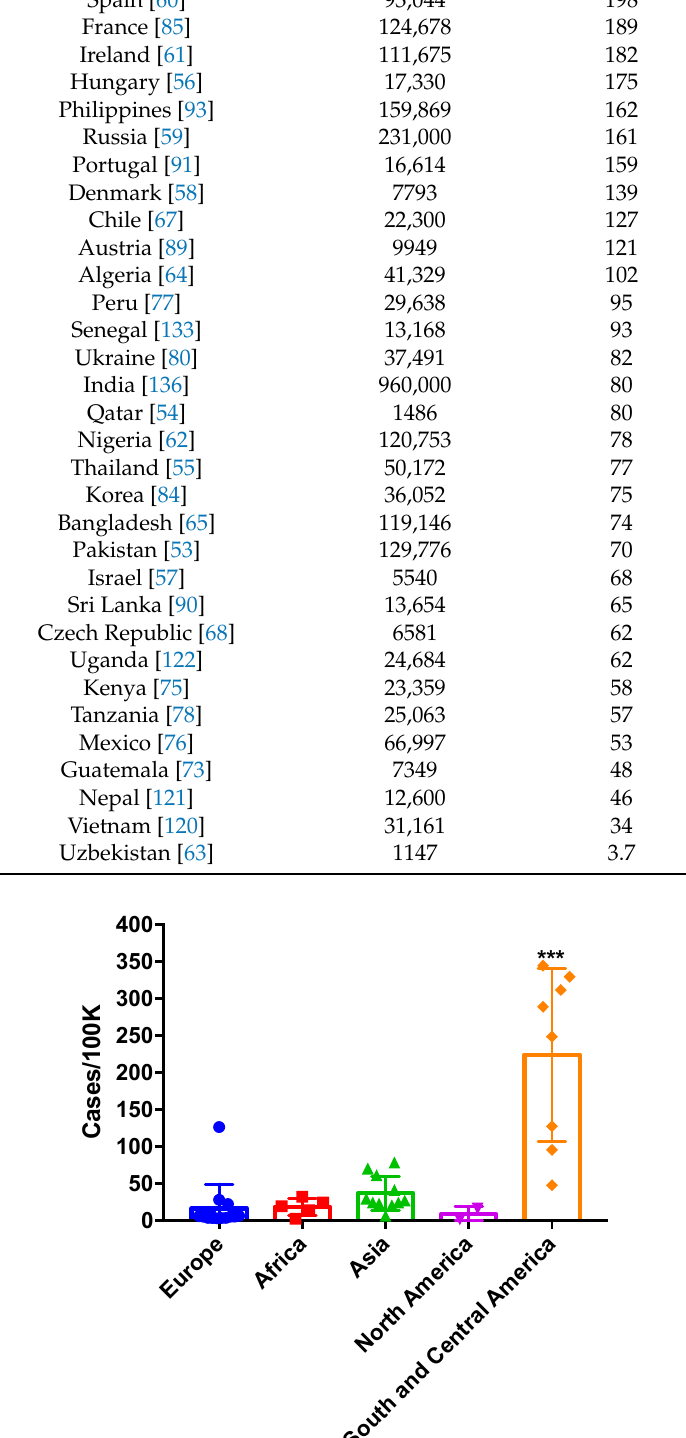
Figure 5. SAFS prevalence across continents. *** p < 0.001.